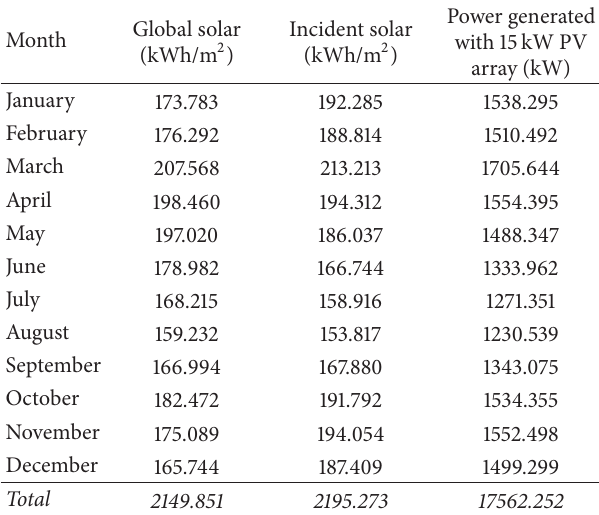
Table 7: Solar resources for the studied